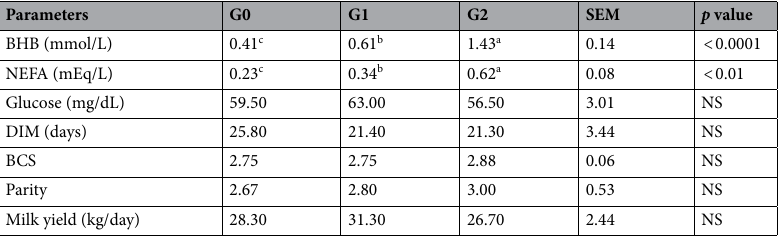
Table 1. Least square means and standard error of the mean (SEM) of main characteristics for each group. BHB β-hydroxybutyrate, NEFA nonesterified fatty acid, DIM days in milk, BCS body condition score, NS not significant. a-c Mean values in the same row which differ significantly ( p value <